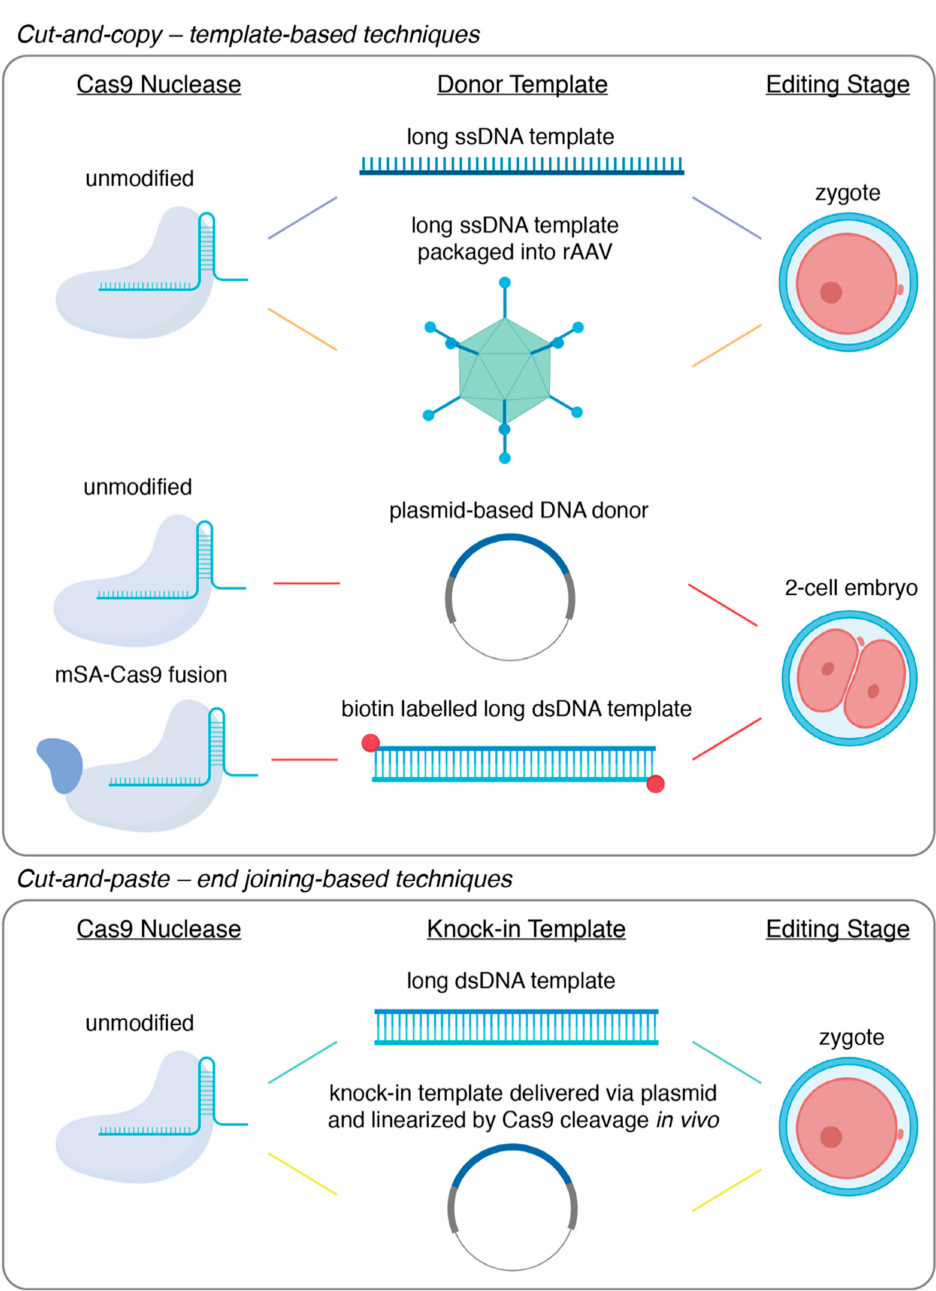
Figure 1. Visual summary of the technologies